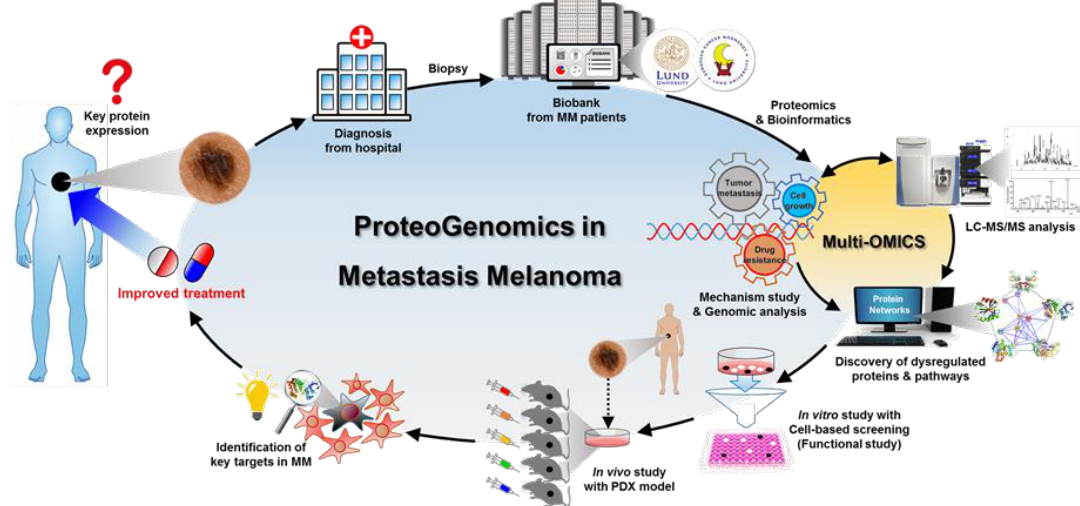
Figure 7. Workflow of proteogenomics in MM. Patient samples are processed by deep proteome